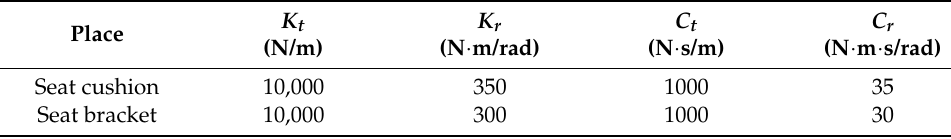
Table 2. High-speed train seat